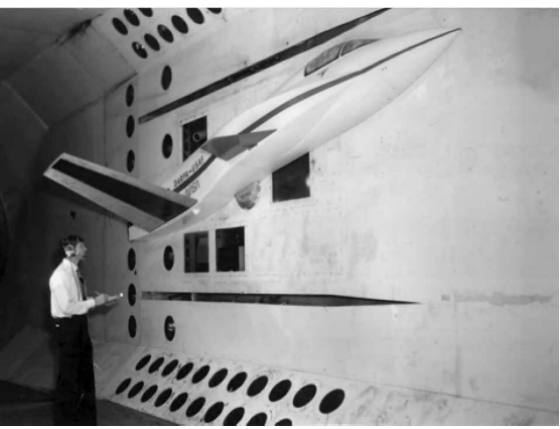
Figure 2. Static aeroelastic wind tunnel test, Adapt with permission from [43].